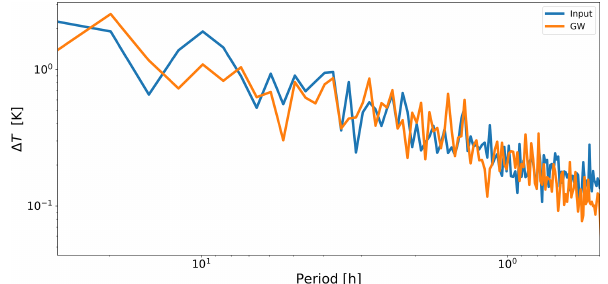
Figure 13. Fourier power spectra of measured temperature fluctua- tions (blue) and of the reconstructed GWs